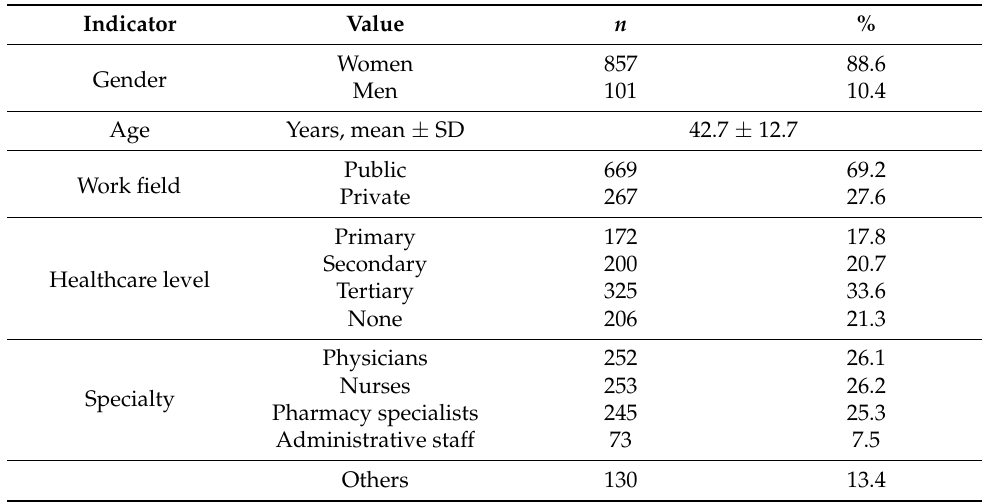
Table 1. Main characteristics of quantitative survey